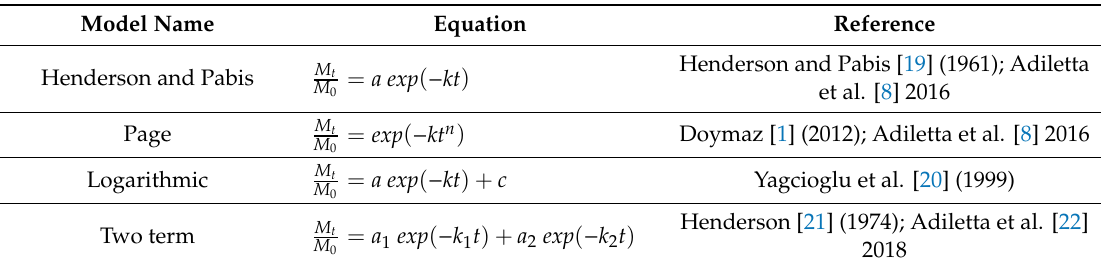
Table 1. Mathematical models applied to drying